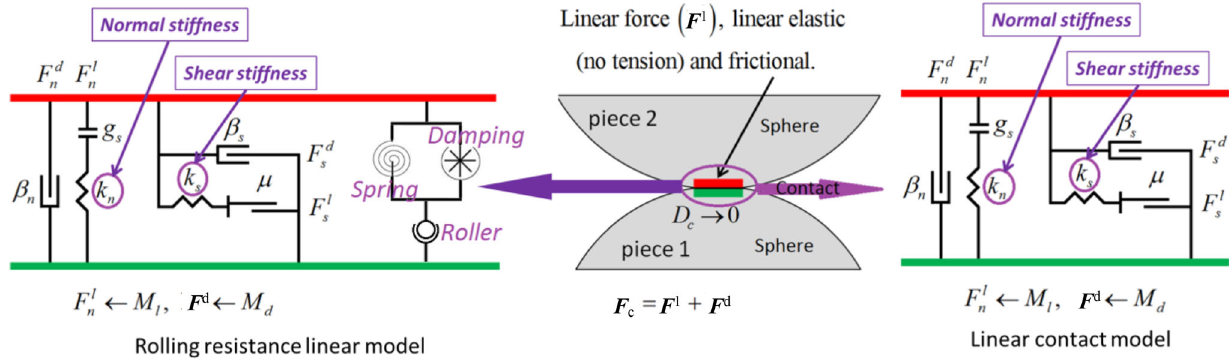
Fig. 2 Diagram of the normal stiffness and shear stiffness (modified after